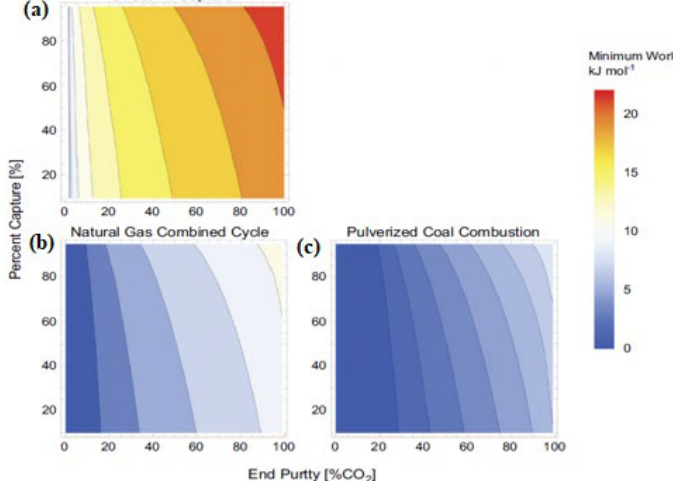
Figure 2. Minimum thermodynamic work of CO 2 separation from ( a ) air, ( b ) natural gas combined cycle flue gas and ( c ) pulverized coal combustion flue gas. Reproduced under the Creative Commons attribution 3.0 license [32] .